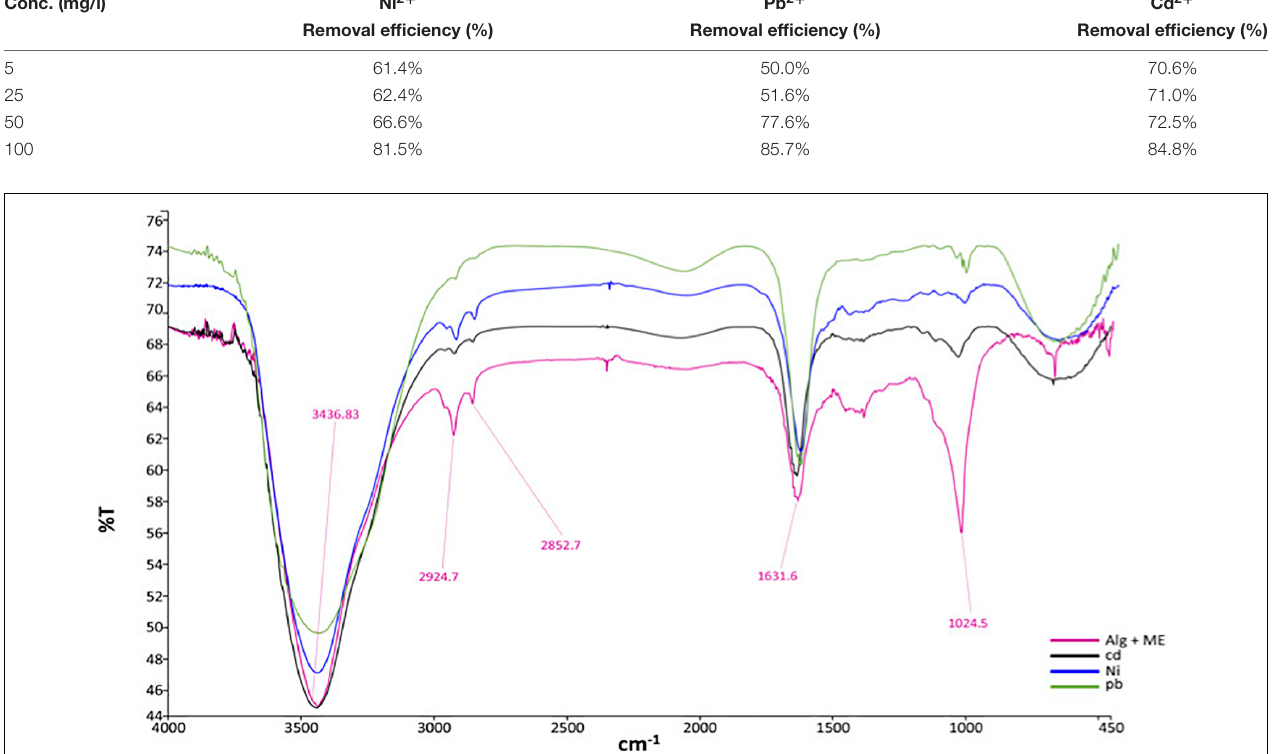
TABLE 1 | Removal efficiency and adsorption capacity of melanin for Ni 2 + , Pb 2 + , and Cd 2 + . Conc. (mg/l)